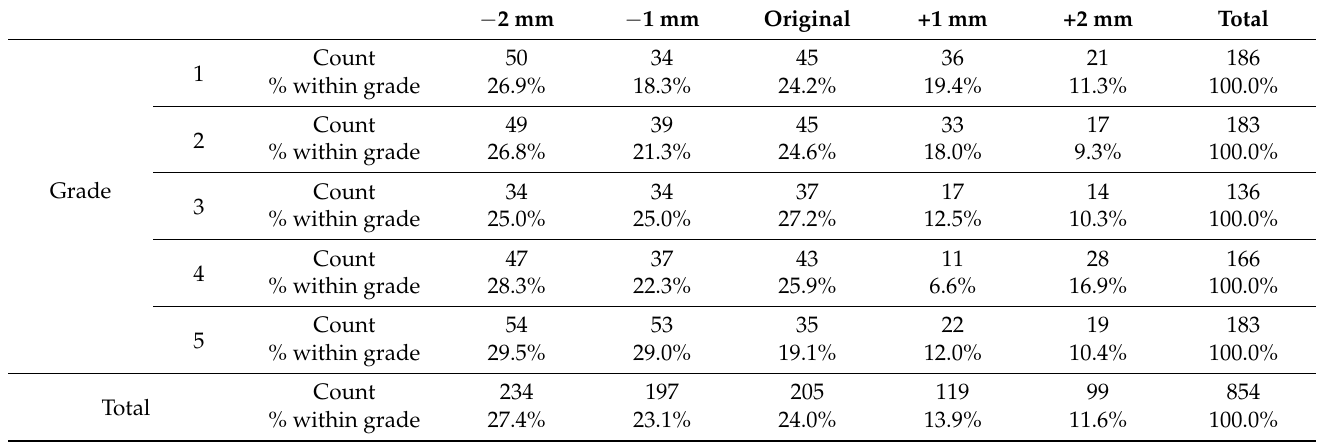
Table 3. Distribution of preferences across grades regarding chin prominence (CP, photo series No.